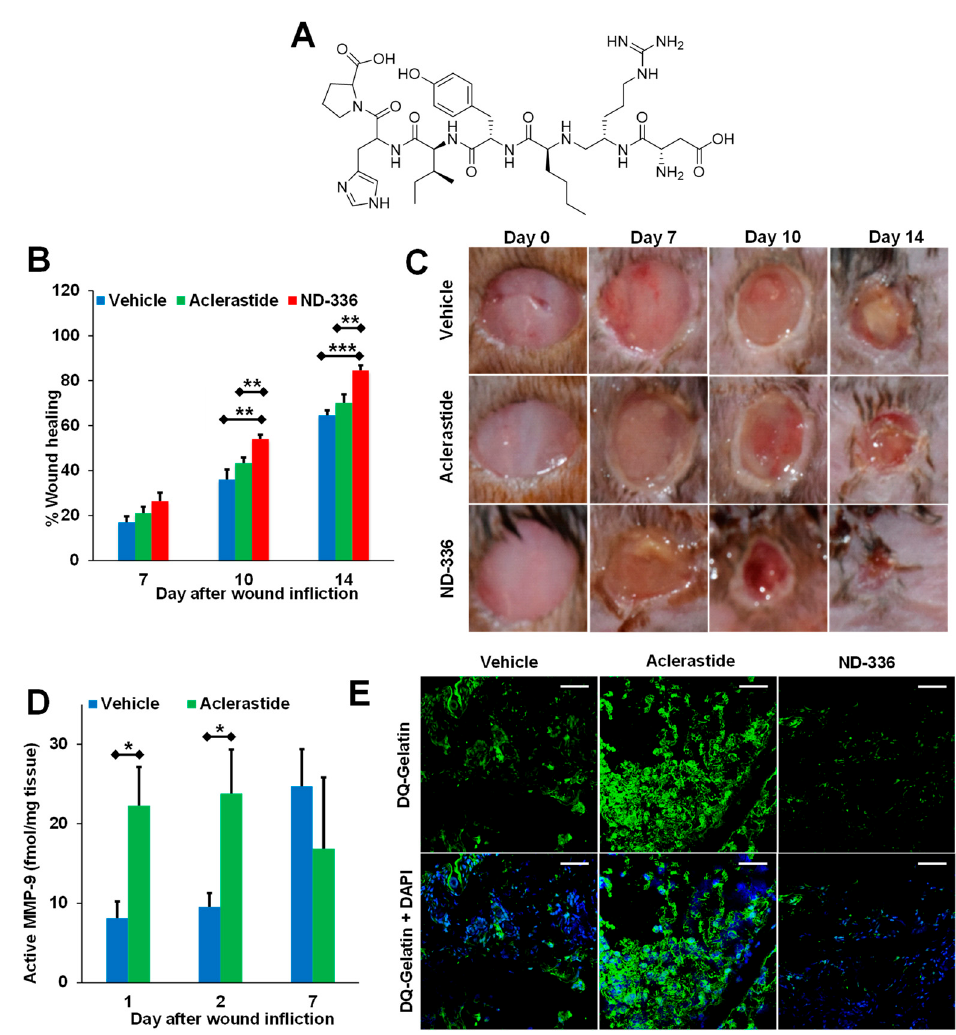
Figure 4. Aclerastide does not accelerate wound healing in diabetic mice when given at a clinically relevant dosing regimen. ( A ) Structure of aclerastide. Mice were treated topically 1 day after wound infliction with ( R,S )-ND-336 or aclerastide at 100 μ g/wound/day for 14 days or vehicle (water). ( B ) Wound closure measurements indicate that ( R,S )-ND-336 accelerates wound healing faster than aclerastide; mean ± SEM, n = 12, 9, and 9 mice for ( R,S )-ND-336 or aclerastide on days 7, 10, and 14, respectively; n = 13, 10, and 10 mice for vehicle on days 7, 10, and 14, respectively; ** p < 0.01, *** p < 0.001 by Mann–Whitney U two-tailed test. ( C ) Representative images of the wounds. ( D ) Increased active MMP-9 levels are observed in aclerastide-treated wounds by the batimastat a ffi nity resin coupled with proteomics; mean ± S.D., n = 3 mice per group per time point, * p < 0.05 by Student’s t two-tailed test. ( E ) Aclerastide treatment increases the detrimental MMP-9 activity in diabetic wounds by in-situ zymography with DQ-Gelatin, whereas MMP-9 activity was inhibited in ( R,S )-ND-336-treated wounds. Adapted from Nguyen et al.